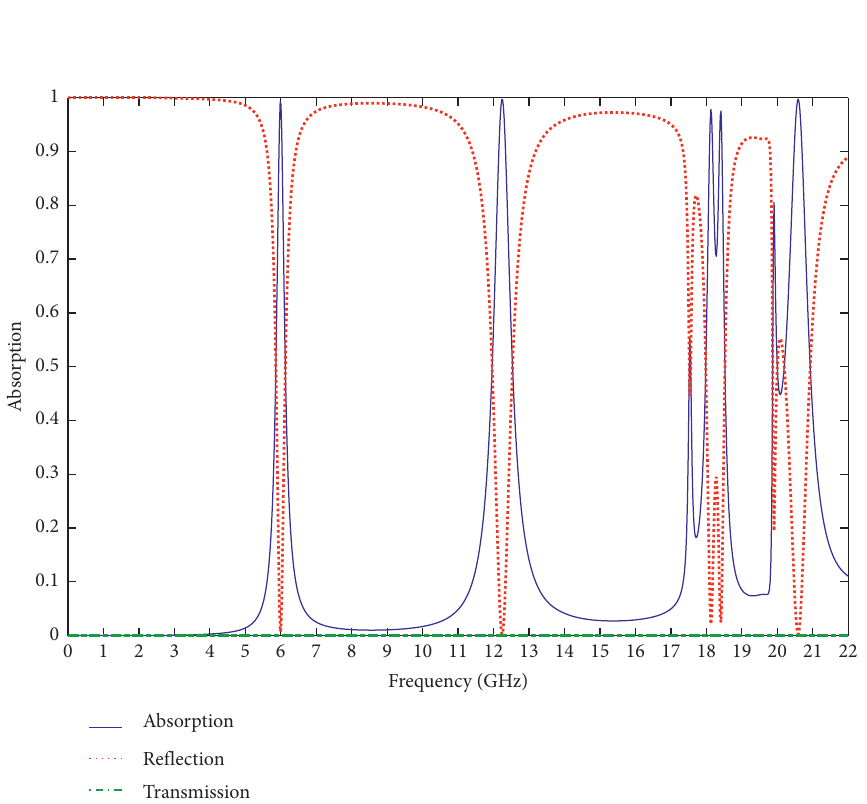
Figure 2: Simulation-optimized absorption, reflection, and transmission